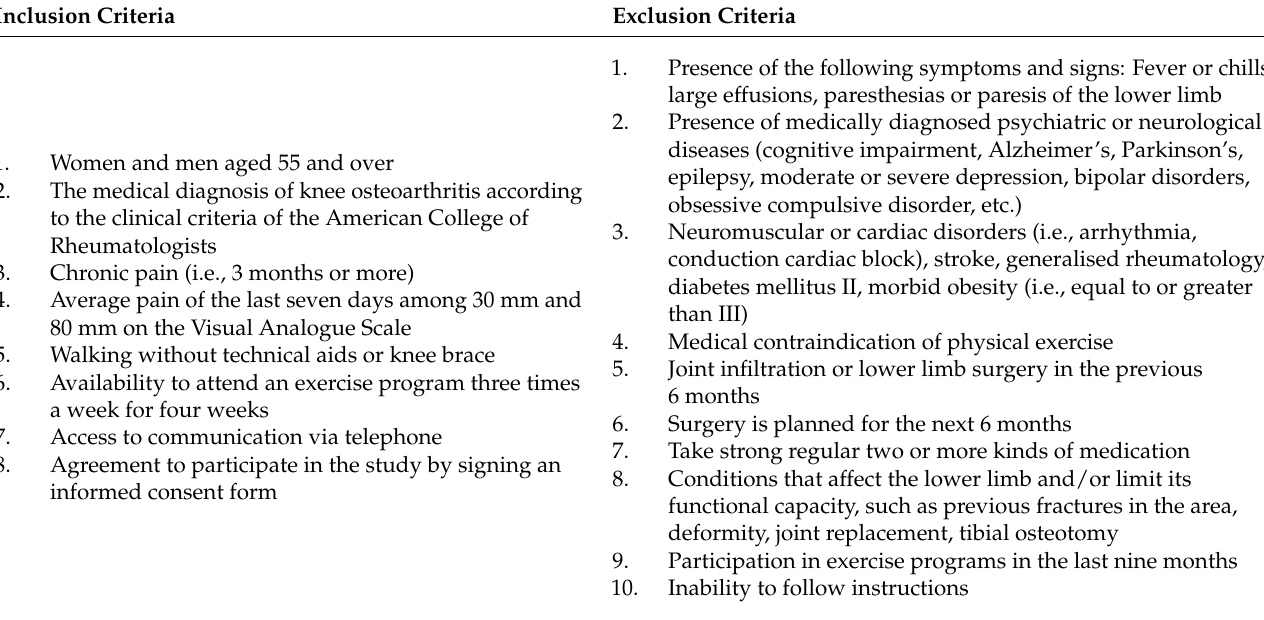
Table 2. Eligibility